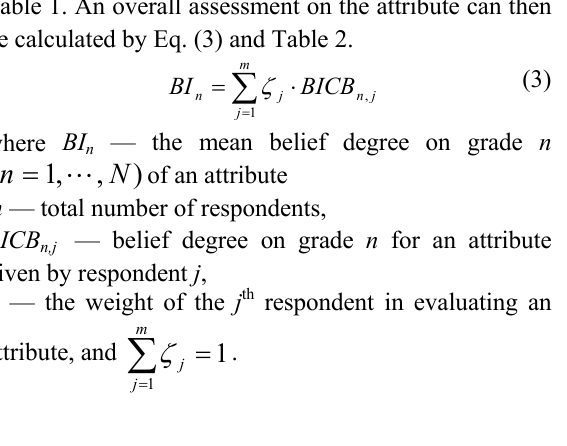
Table 1 Proposed model to account for uncertainty in assessment